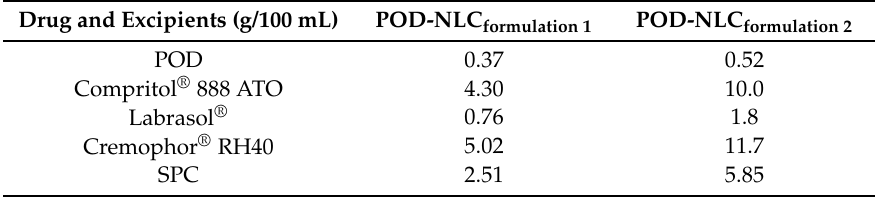
Table 1. Formulation of POD-NLCs. PC: